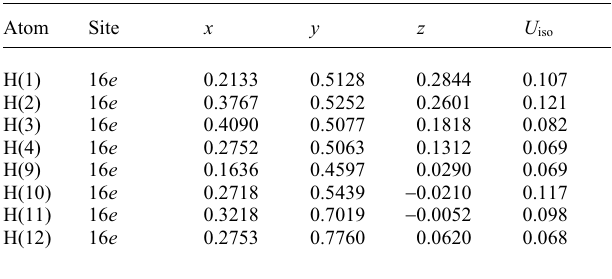
Table 1. Data collection and